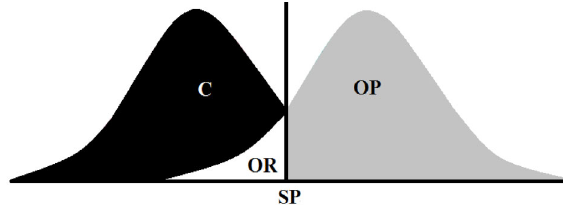
Figure 2. Schematic representation of the criterion used to compose the groups. SP: point of separation (cutoff); (C) composition of the control; OP: obese-prone; OR: obese-